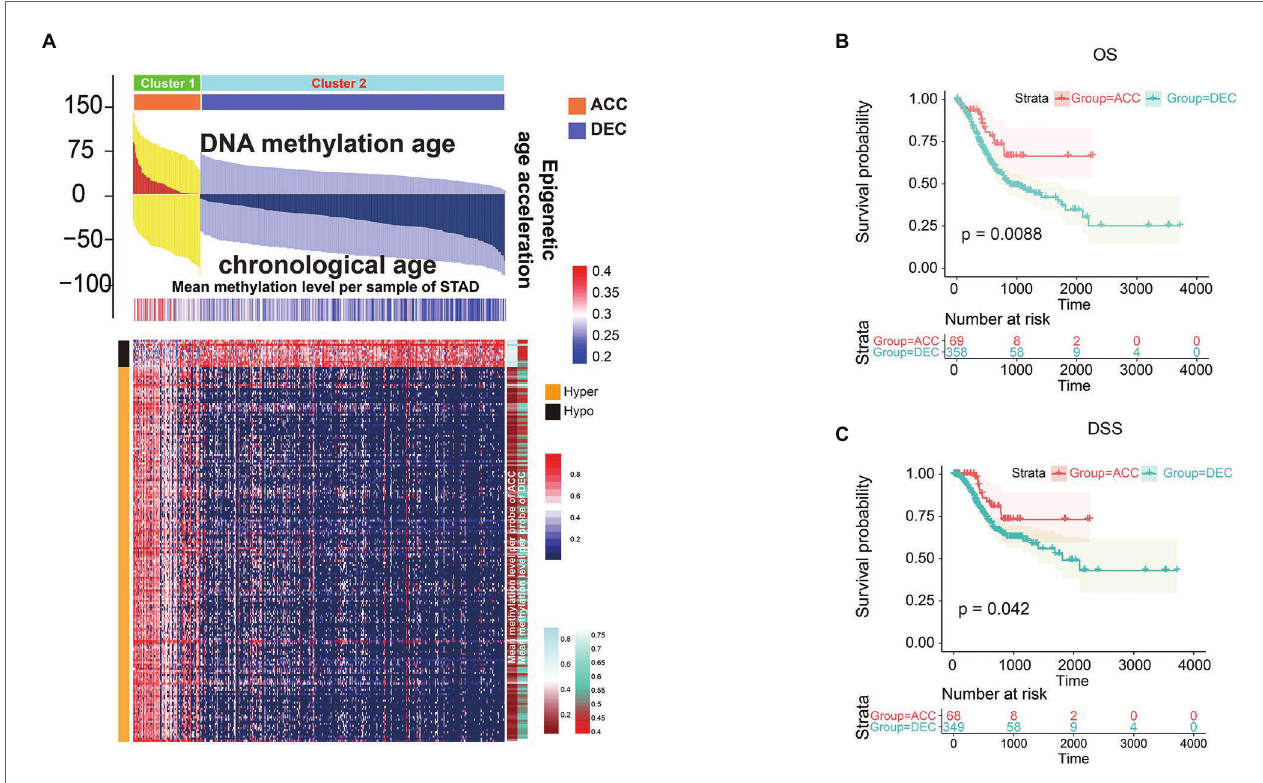
FIGURE 3 | Prognostic value of epigenetic age acceleration in STAD patients. Heatmap showing differential DNAm pattern in CpG islands between DNAmAge-ACC and DNAmAge-DEC group (A) . Patients belonging to DNAmAge-ACC showed significantly favorable prognosis in terms of overall survival (OS; B ) and disease-specific survival (DSS; C ). The association between DNAm age shift value and the prognosis of STAD including OS (B) and DSS (C) was presented with cubic spline graphs of the hazard ratio (solid red line) and 95% confidence interval (dotted black line). OS, overall survival; DSS, disease specific survival. ACC, accelerated; DEC, decelerated; STAD, stomach